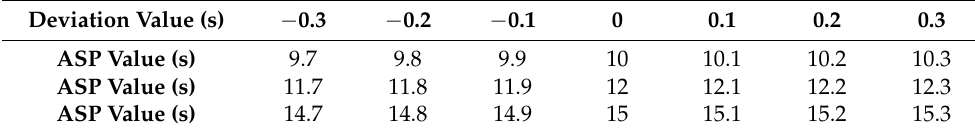
Table 6. The radar ASP deviations and the corresponding ASP values.